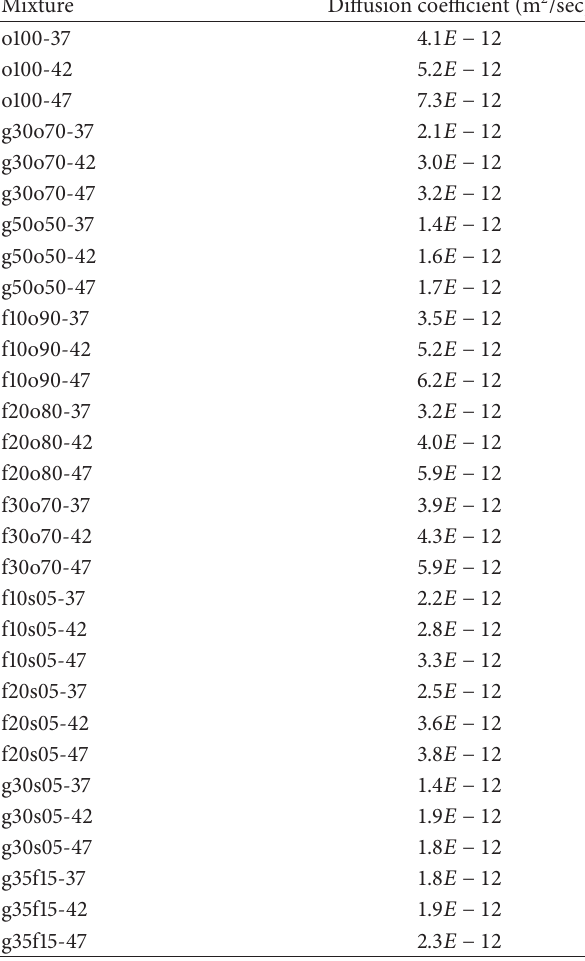
Figure 6: Decrease in errors with increasing